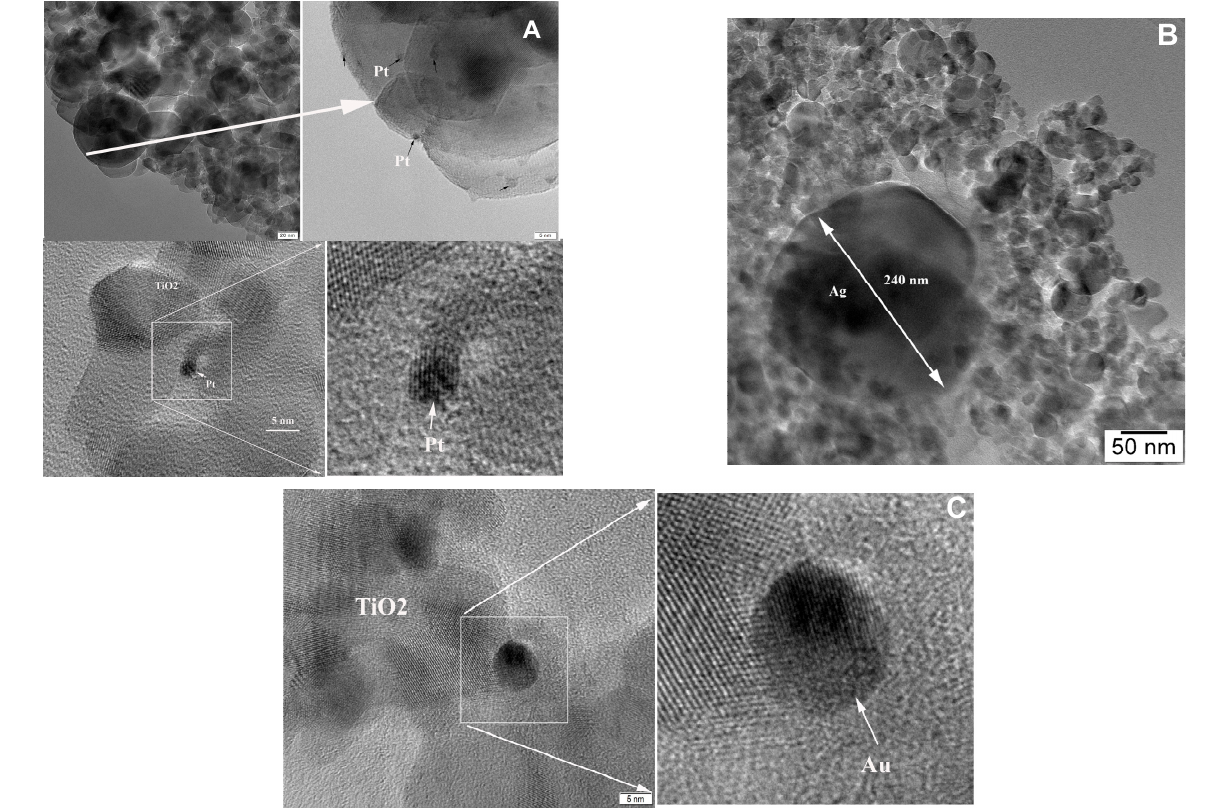
Figure 1. Suggestive TEM images of metal-loaded TiO 2 samples: Pt/TiO 2 ( A ), Ag/TiO 2 ( B ) and Au/TiO 2 ( C ). The most relevant characterization data obtained by various experimental methods are presented comparatively in Table 1. More details are given in Supplementary Information. Table 1. Comparative characterization data of investigated materials collected from EDAX (Energy Dispersive X-ray Analysis), XPS (X-ray Photoelectron Spectroscopy), and TEM measurements. Samples